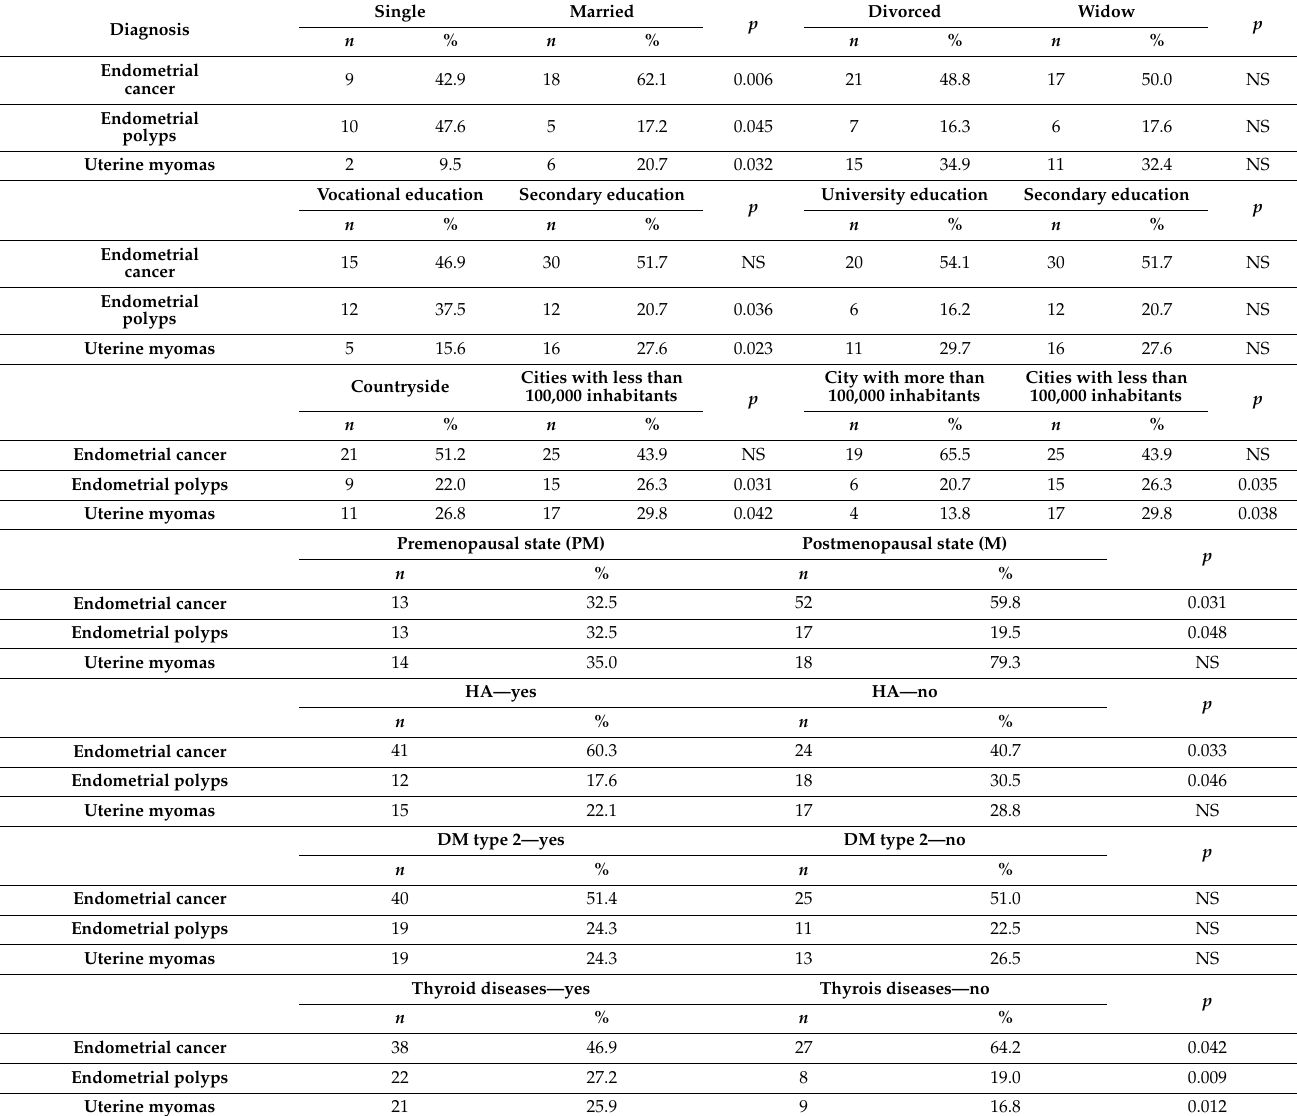
Table 3. Characteristics of patients: BMI, body mass index; WC, waist circumference; HA, arterial hypertension; DM type 2, diabetes mellitus type